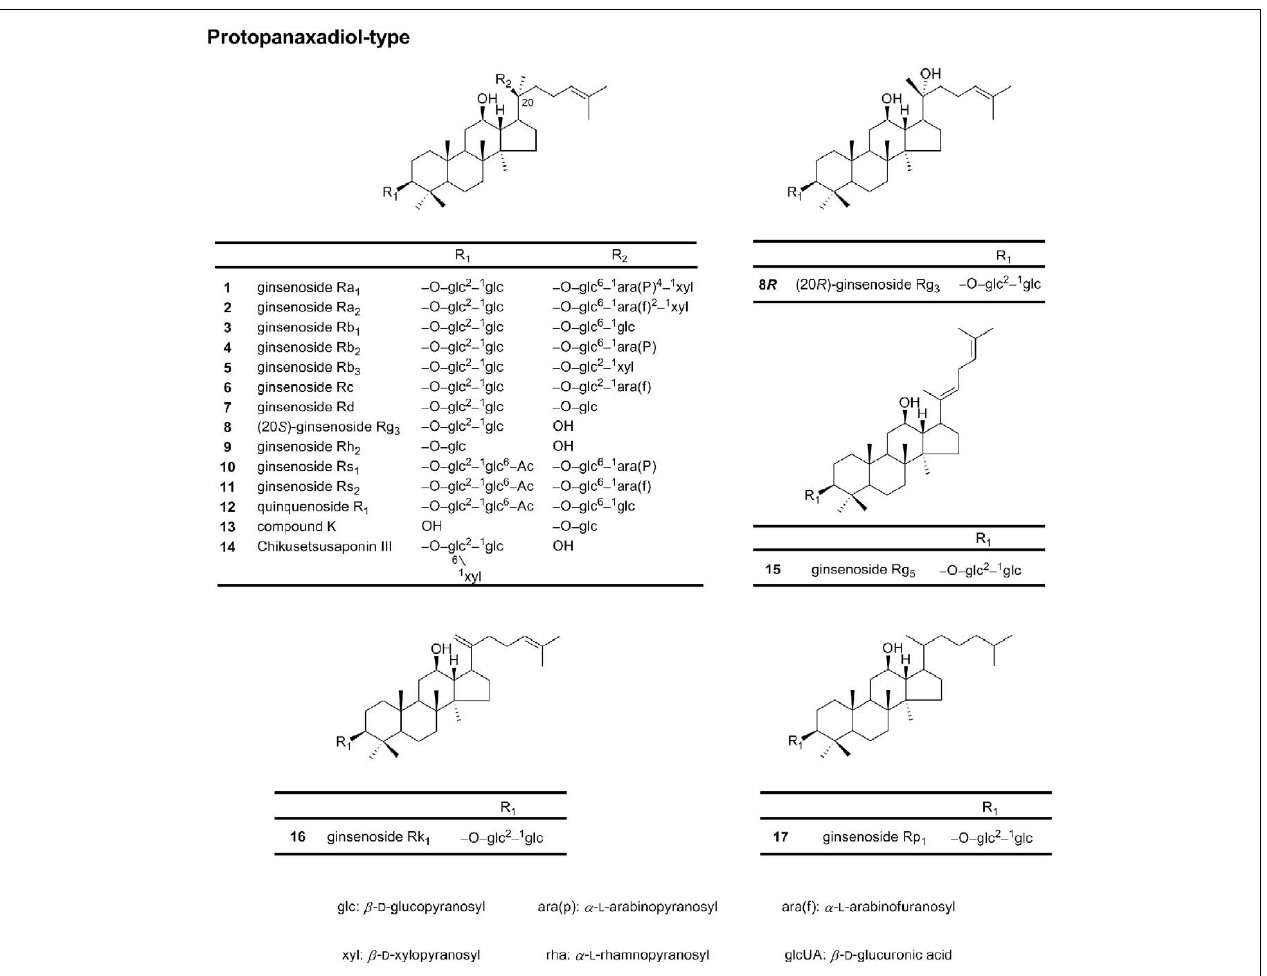
FIGURE 1 | Chemical structures of protopanaxadiol-type